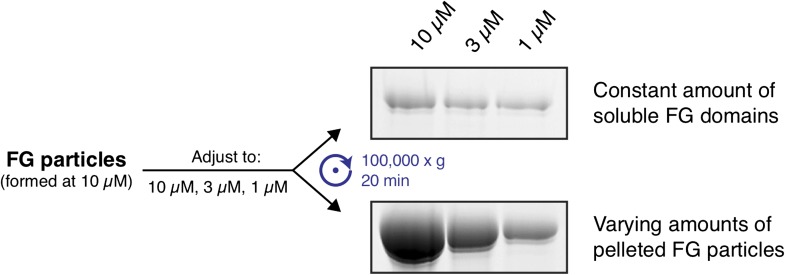
Reversibility of FG particle formation.